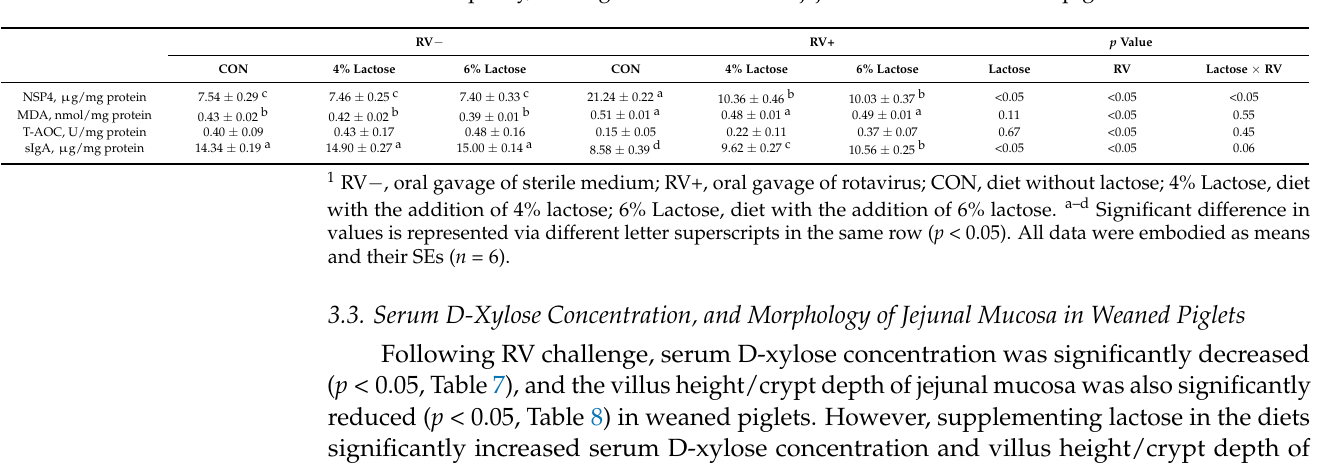
Table 6. Effect of dietary lactose supplementation and/or RV challenge on rotavirus NSP4 level, antioxidant capacity, and sIgA concentration of jejunal mucosa in weaned pigs 1 .